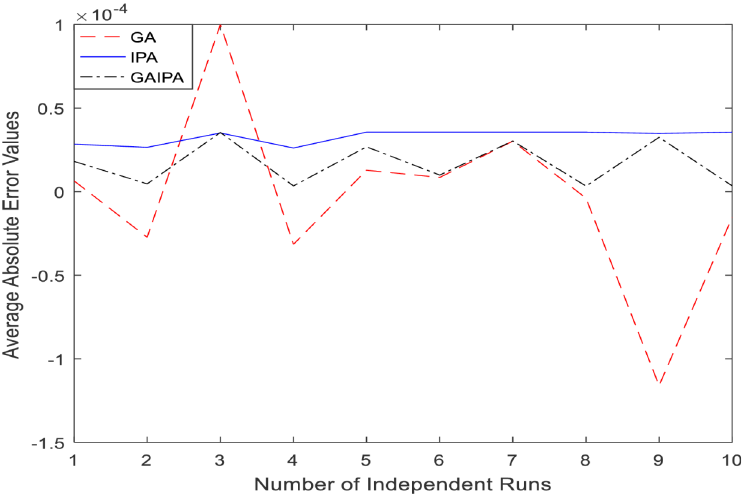
Fig 5. Graphical representation of average absolute errors for Example #01 when δ = 0.6 using B-Polynomial.